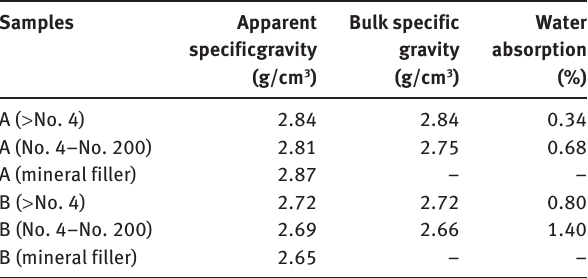
Table 3 Test results of specific gravity and water absorption.